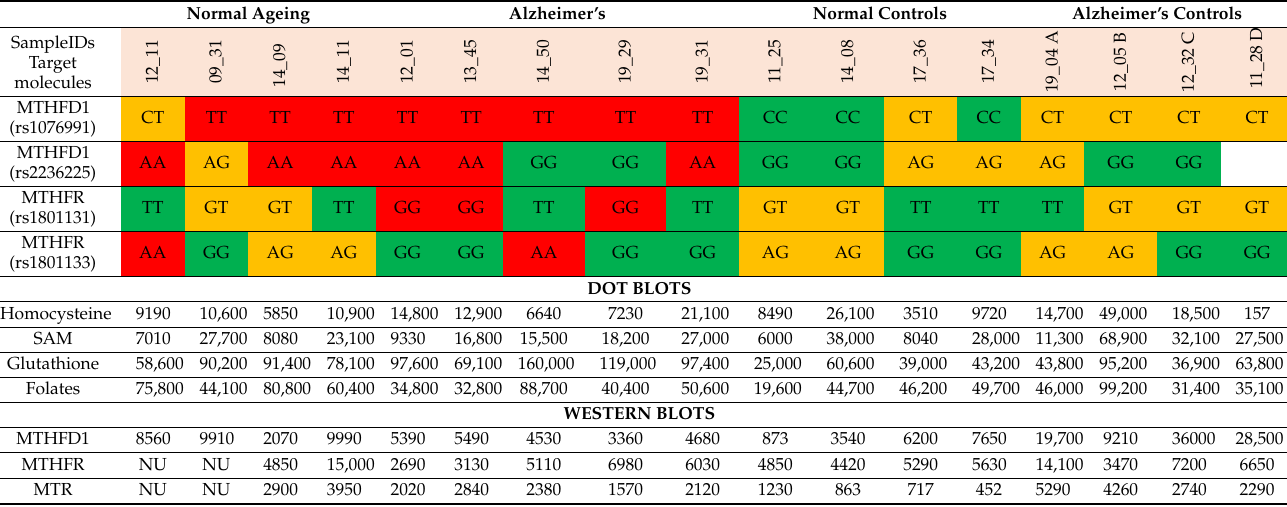
Table 6. Samples used in folate analyses correlated to gene SNP data.